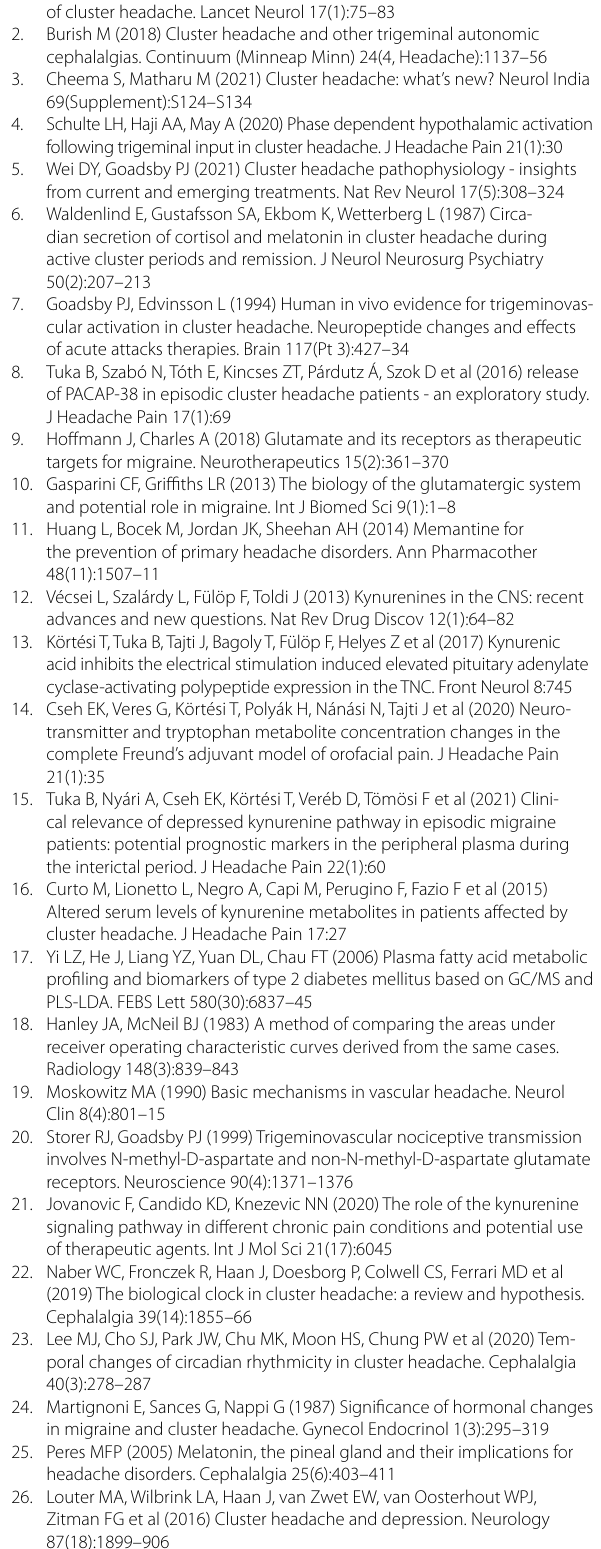
Additional file 2: Supplementary Table 2. Applied MRM transition set- tings for TRP metabolites utilizing Waters TQ-S Micro MS. Analyte levels in human plasma were determined using data mentioned in this